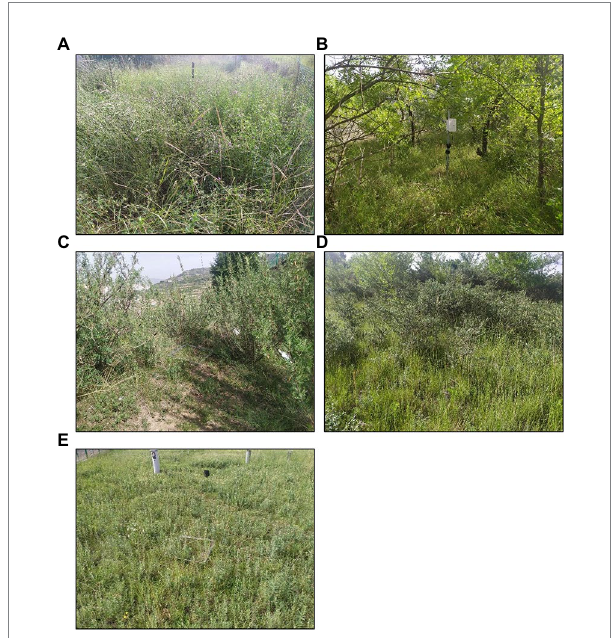
FIGURE 2 Photographs of sampling plots with different land use patterns: